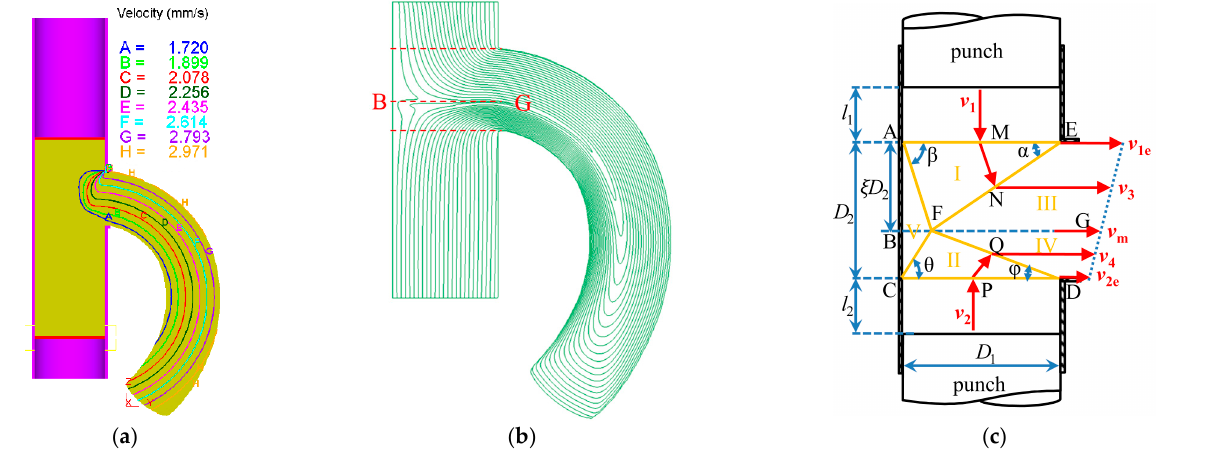
Figure 27. ( a ) Flow velocity gradient across the die orifice, ( b ) flow lines, ( c ) two dimensional deformation model. Reproduced with permission from ref. [100]. Copyright 2018 Elsevier Ltd.